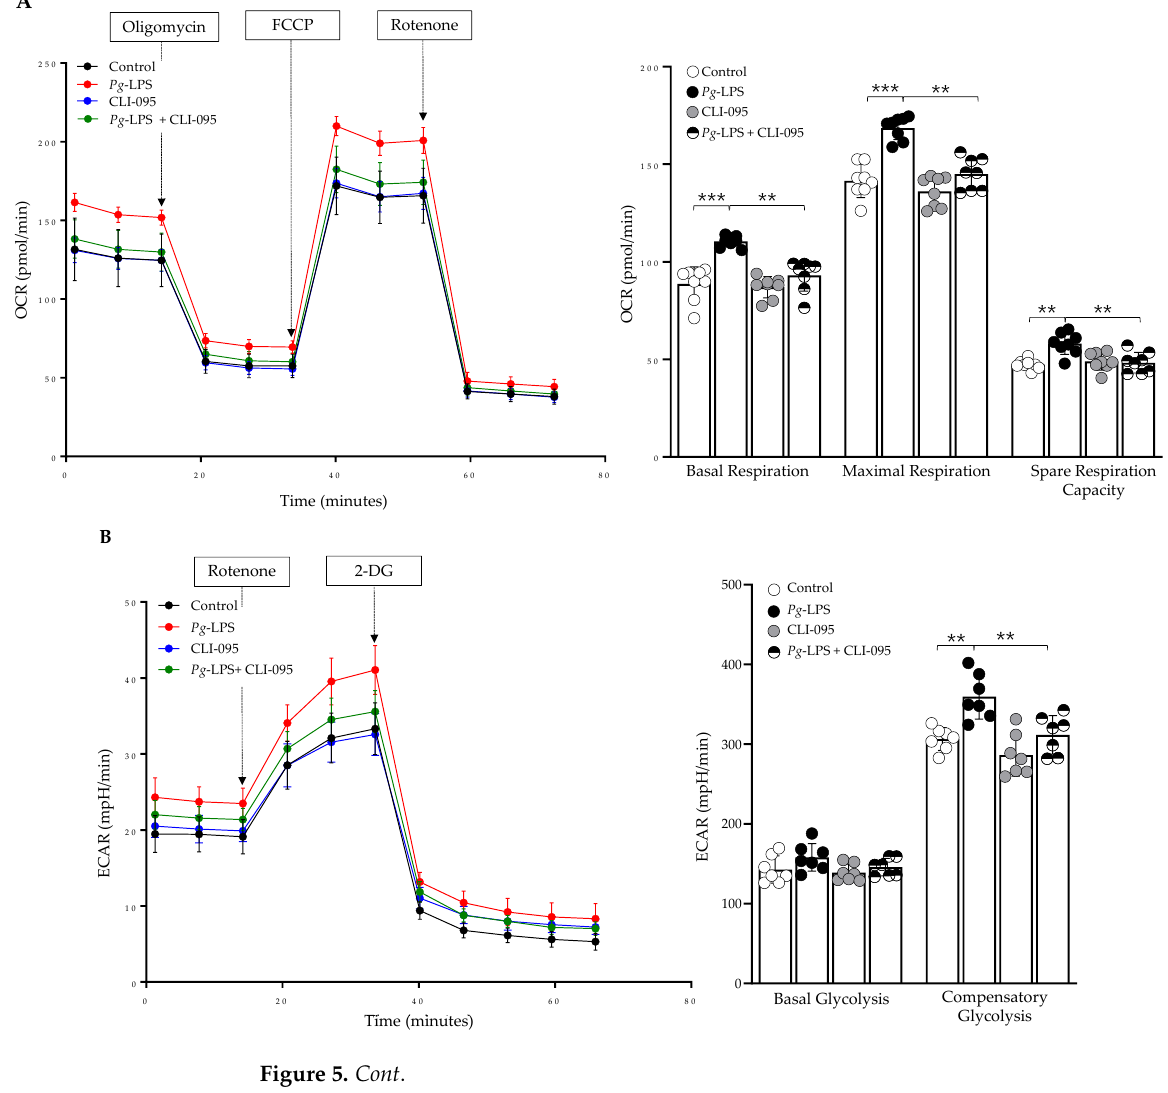
C Figure 5. Cont